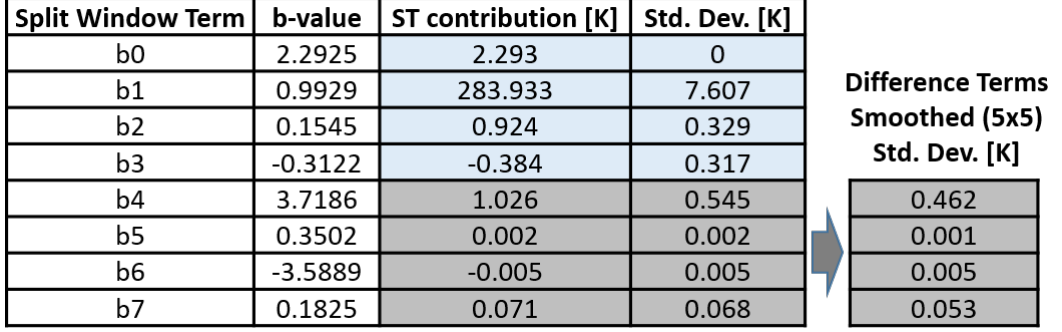
Figure 5. Table illustrating the contribution of each term from Equation (1) to the final surface temperature product shown in Figure 3. Columns 3 and 4 of this table were populated by calculating the scene-wide mean and standard deviation, respectively, of each term in Equation (1). Note that the additive terms (highlighted in blue) contribute most of the overall magnitude (column 3) and variability (column 4) to the final ST product. When compared to the difference terms in column 4 (highlighted in gray), the zoom window suggests that smoothing the difference terms has little impact on scene-wide